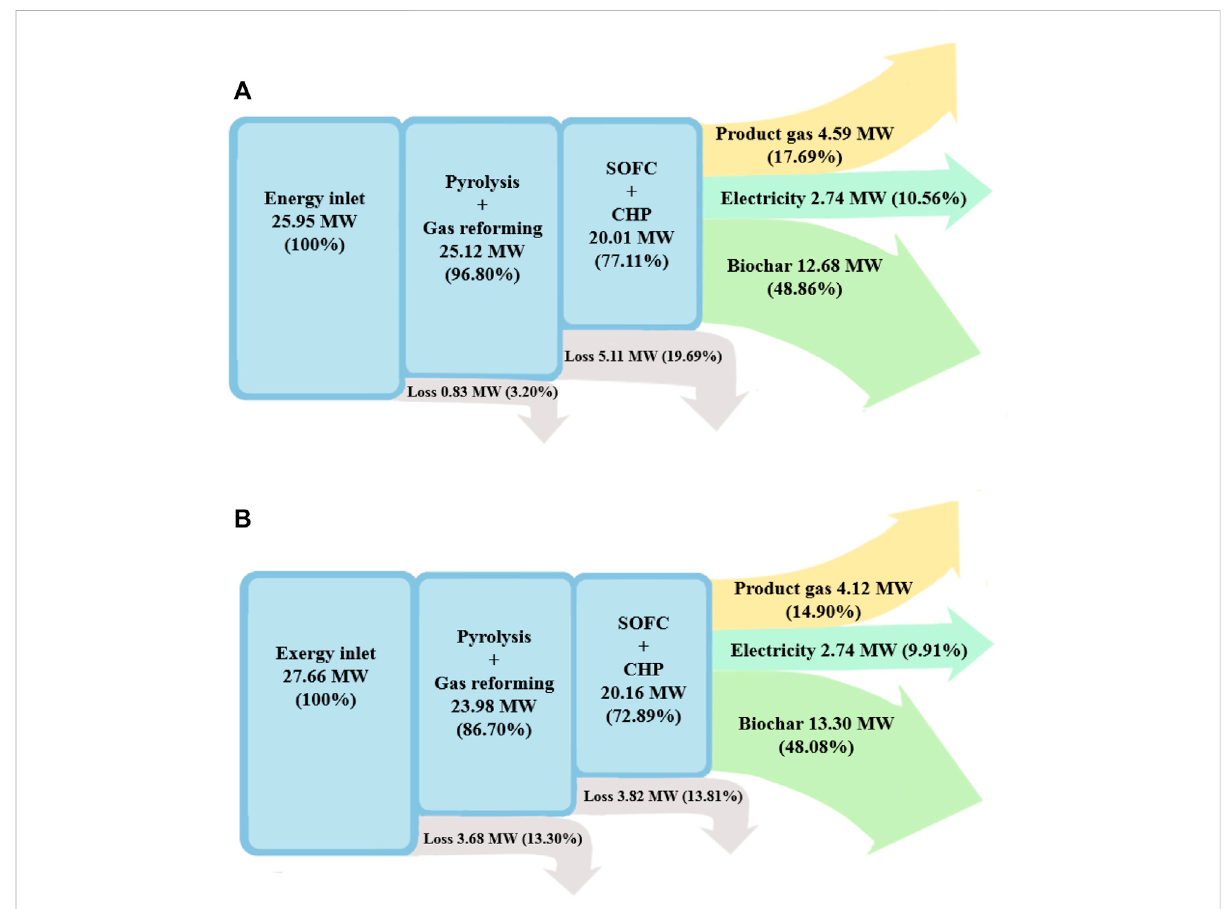
FIGURE 3 Sankey diagram of the BP-SOFC-CHP system: (A) energy, and (B)